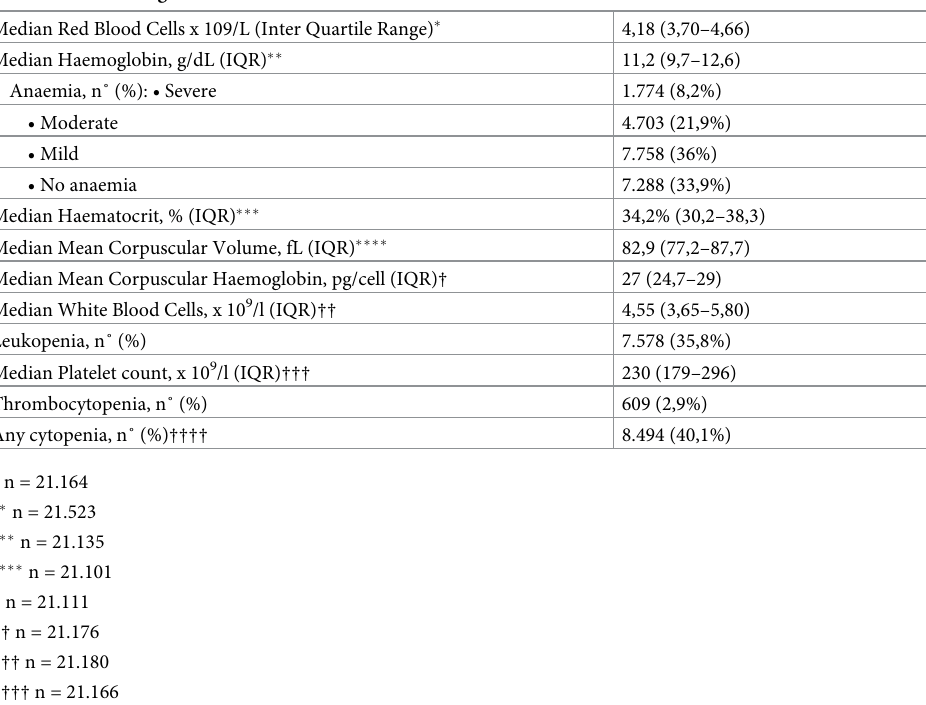
Table 2. Haematological features of the